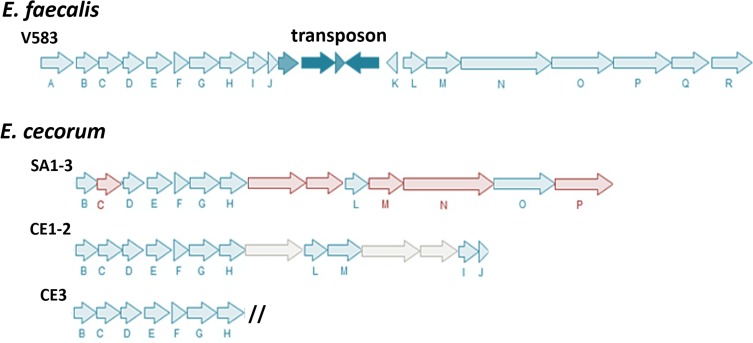

epa-like Locus of EC.
epa orthologs identified in EC strains are presented as arrows labeled with letters that correspond to epa-gene orthologs. Orthologs found to be highly conserved in pathogenic EC are shaded in red. Pathogenic strains have a conserved chromosomal arrangement that is more similar to the epa-locus of E. faecalis V583 than commensal strains. The core epa-like locus which contains epaB-H is conserved among all strains; however, commensal EC strains have a variable arrangement downstream from this core region. Orthologs conserved in pathogenic strains: epaC, epaM, epaN, and epaP (red) are located within and downstream from the core epa-like locus. In all strains, orthologs to epaA (not shown) are found at distant genomic locations (see Fig 5). epaR and epaI (not shown) are conserved in pathogenic strains but are found in distant chromosomal locations (see Fig 5).